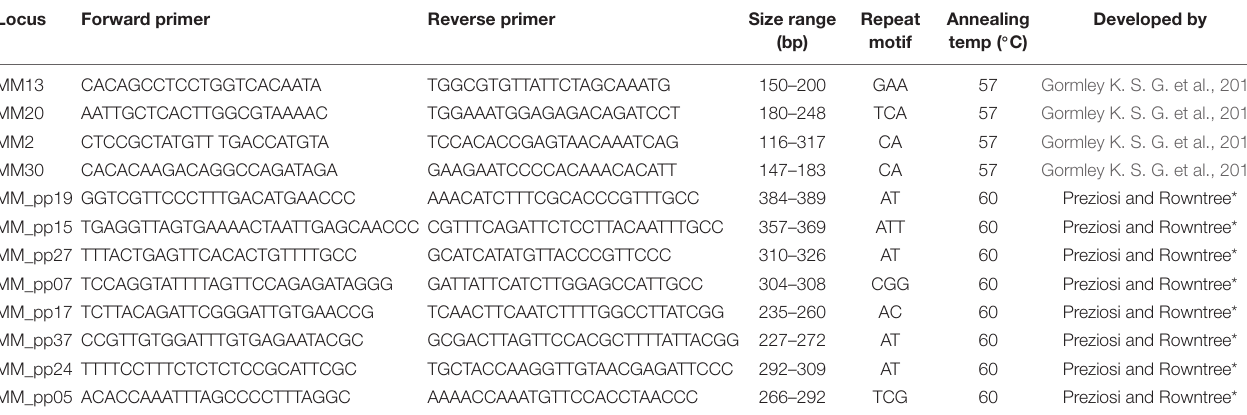
TABLE 2 | Microsatellite markers used in genetic analyses including forward and reverse primer sequences, amplicon size range, repeat motif, annealing temperature and marker developer. Locus Forward